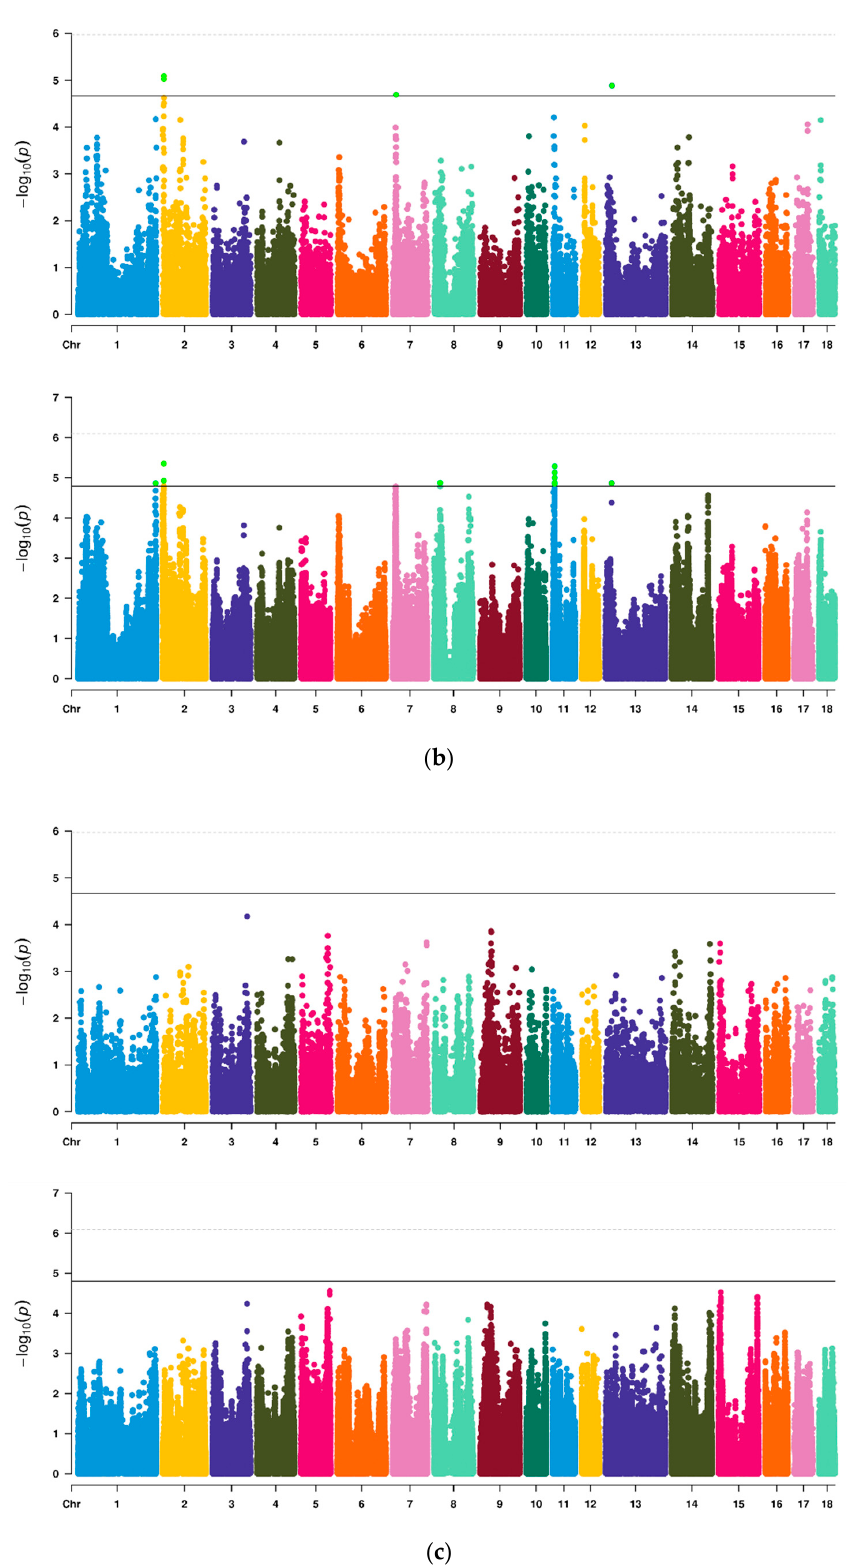
Figure 1. Manhattan plots of GWAS for three vulvar traits of Suhuai pigs based on Chip or imputed data. ( a ) VL; ( b ) VW; ( c ) VA. In plots ( a – c ), the above plot was generated using Chip data and the below plot was generated using imputed data. The solid line and the dotted line in Manhattan plots represent the suggestive threshold level and the genome wide threshold level,